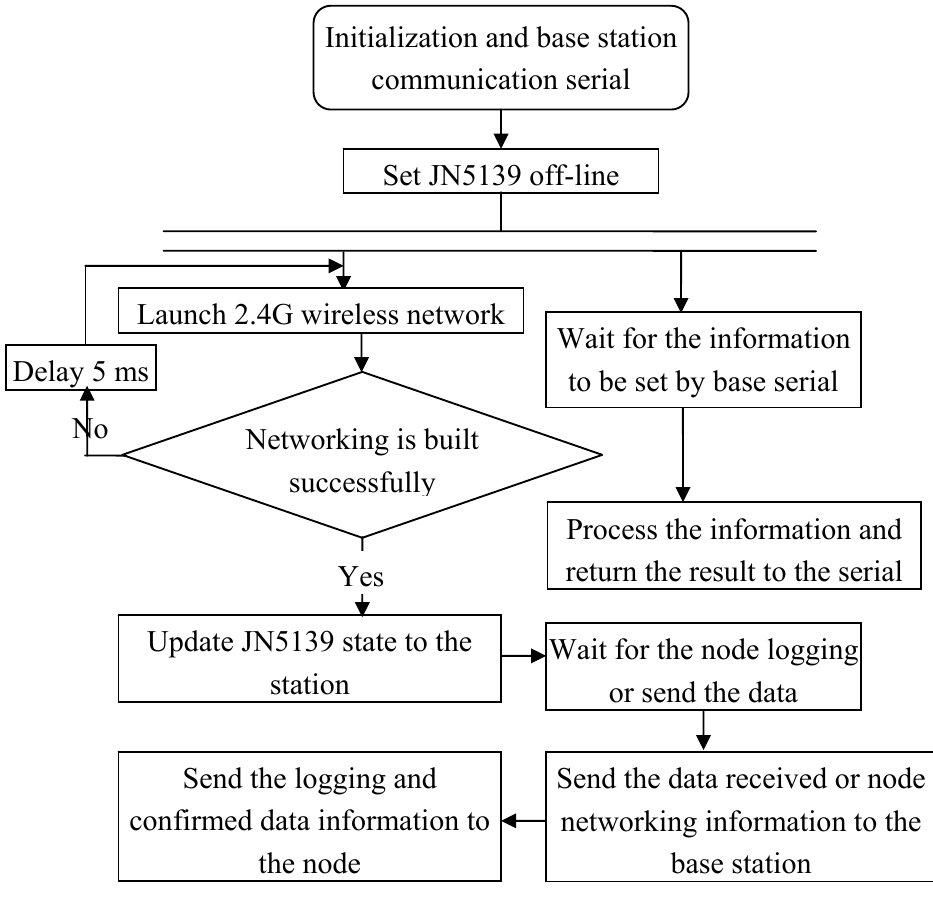
Figure 10. The flow chart of the 2.4G (JN5139) program in the base